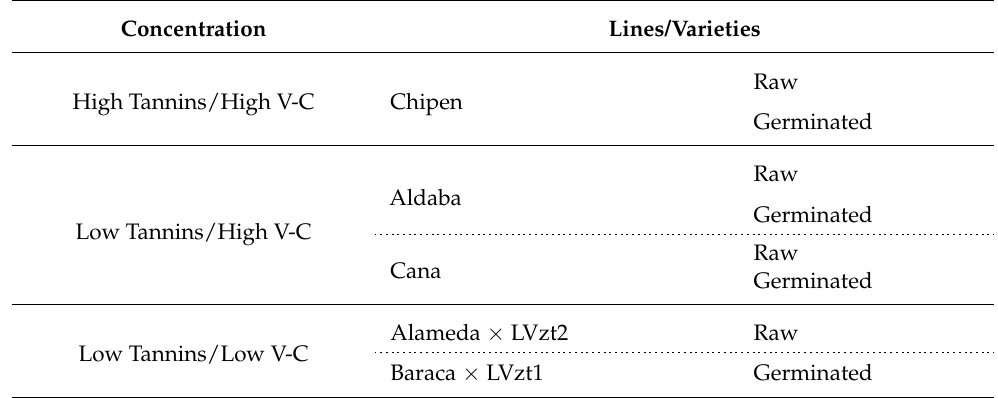
Table 1. Concentration of tannins and vicin and convicin in the different faba bean lines and varieties. Concentration Lines/Varieties